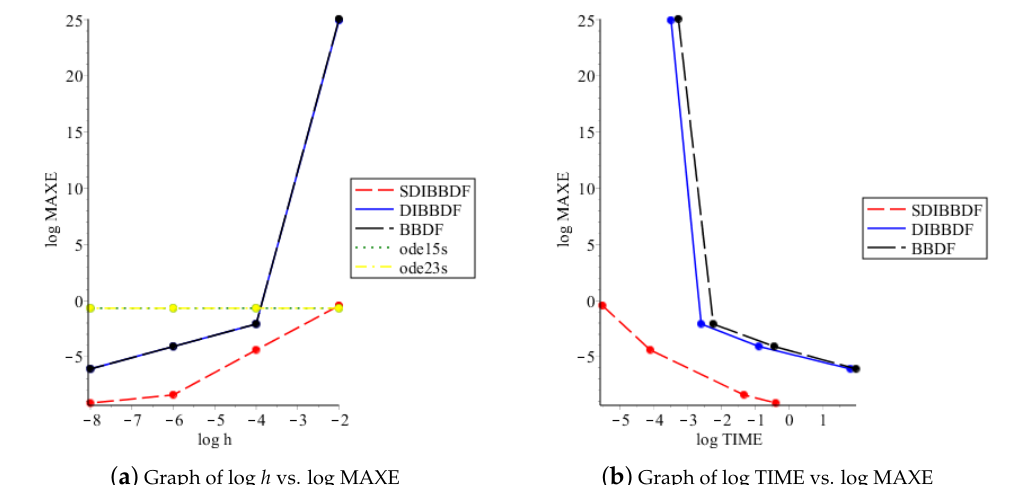
Figure 9. Efficiency curves for test problem